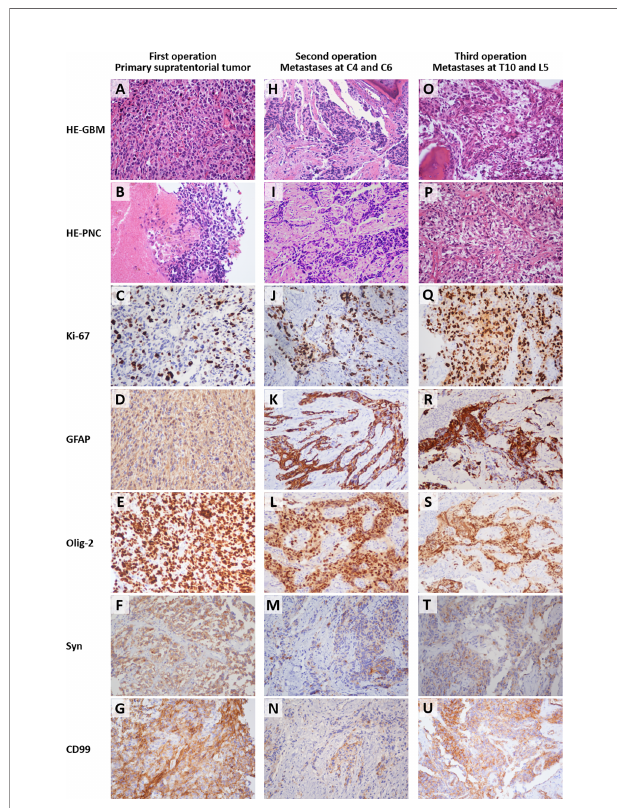
FIGURE 6 | Histological images (200 × magni fi cation) of the formalin- fi xed paraf fi n-embedded sections from the primary supratentorial tumor (A – G) , cervical spine metastases (H – N) , and thoracolumbar metastases (O – U) . The types of staining and sources of the specimens were labeled on the left side and the top, respectively. The osseous tissues were included in the right upper corner of fi eld H and left lower corner of fi eld O. HE, hematoxylin and eosin staining; GBM, glioblastoma multiforme, refers to the fi eld with typical GBM characteristics; PNC, primitive neuronal component, refers to the fi eld with primitive neuroectodermal tumor-like features; GFAP, glial fi brillary acidic protein; Olig-2, oligodendrocyte transcription factor 2; Syn, synaptophysin; CD99, cluster of differentiation 99 (MIC2). The small round blue cells under HE (B, I, P) and the positive immunohistochemical staining of Syn (F, M, T) indicated the existence of PNC. The Ki-67 labeling index ranged from 40%-80% (C, J, Q)